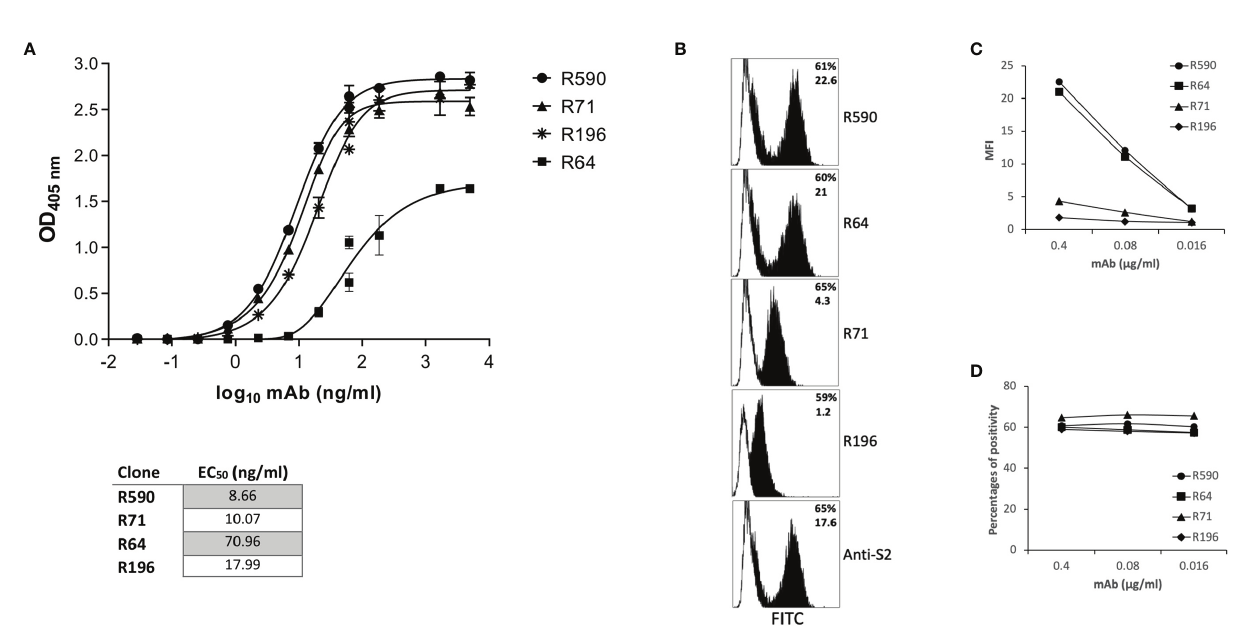
FIGURE 2 | Characterization of anti-RBD mAbs. (A) ELISA-binding af fi nity of puri fi ed mAbs to rRBD produced in mammalian expression system. Error bars indicate standard deviations of technical triplicates from a representative experiment repeated twice. Table indicates the EC 50 of isolated mAbs. (B – D) HEK293T cells transfected with plasmid coding for wild type transmembrane homotrimeric spike (pSpike-C3) were incubated with anti-RBD mAbs at 0.4 µg/ml ( B , black histograms) or with murine IgG1 control mAb ( B , white histograms) or with serial dilution of mAbs starting from 0.4 µg/ml (C, D) followed by staining with anti-mouse FITC-conjugated mAb before analysis by fl ow cytometry. An anti-S2 mAb was used as control to determine the percentage of transfection. In (B) the upper numbers indicate the percentages of positive cells, lower numbers indicate mean fl uorescence intensity. In (C) mean fl uorescence intensity (MFI) of staining is shown. In (D) percentages of positive stained cells is shown. A representative experiment of three is